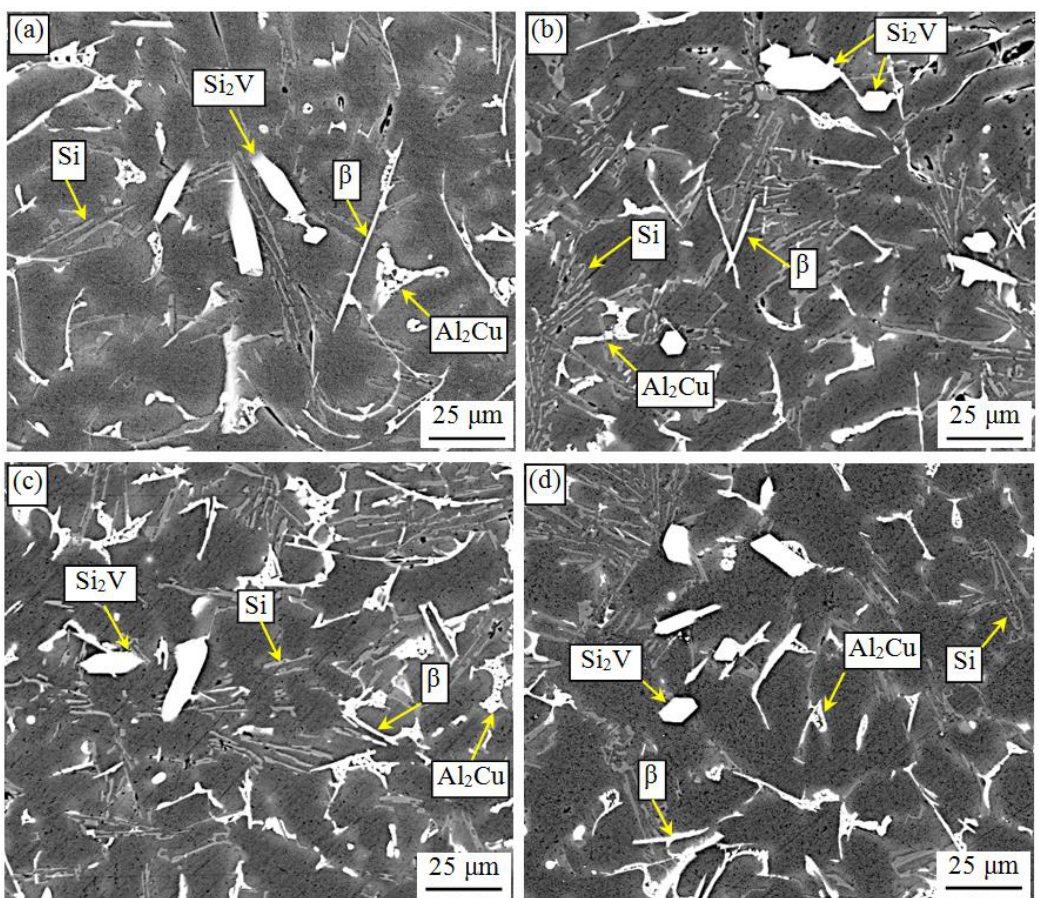
Figure 7. SEM micrographs of as-cast gravity casting A3 alloy treated by different physical fields ( β stands for β -Al 5 FeSi): ( a ) no treatment; ( b ) UV; ( c ) ES; ( d ) UV-ES. Table 4. Average size of β-Al 5 FeSi and Si 2 V phases of the alloys treated by different physical fields.